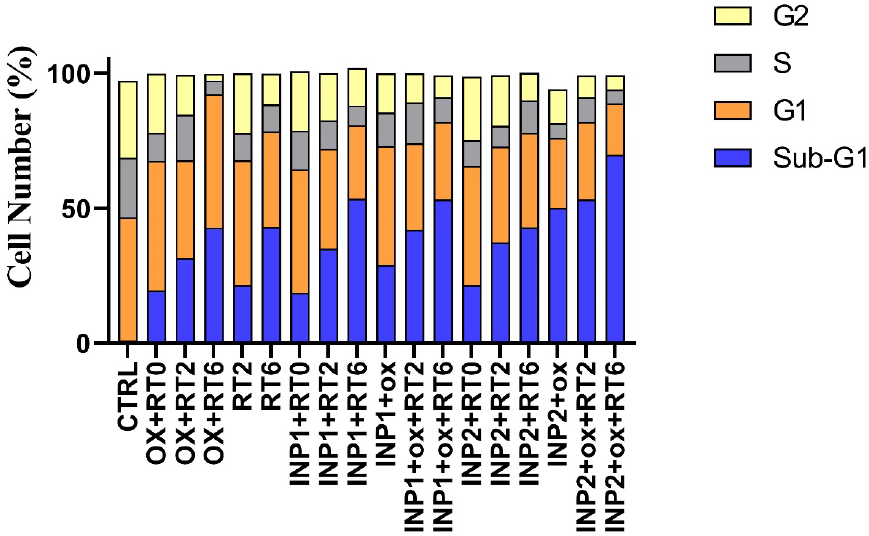
Figure 8. The effect of different formulations on HT-29 cell cycle profiles compared to control. Abbreviations: INP1, iodine nanoparticle 1. INP2, iodine nanoparticle 2. RT0, Radiotherapy at 0 Gy; RT2, Radiotherapy at 2 Gy; RT6, Radiotherapy at 6 Gy; and OX, Oxaliplatin.